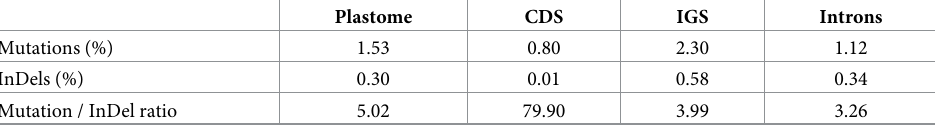
Table 4. Frequency of substitutions/mutations and insertions/deletions (InDels) among the plastome sequence.